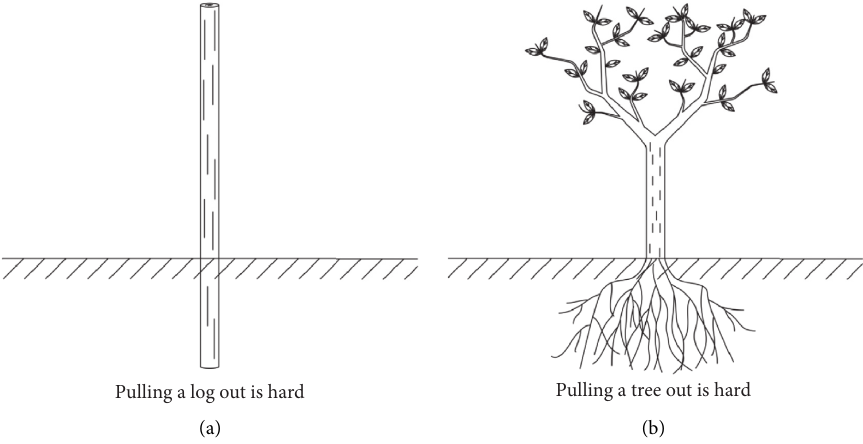
Figure 6: Visual explanation of working principle of dissolution-rebond anchor.